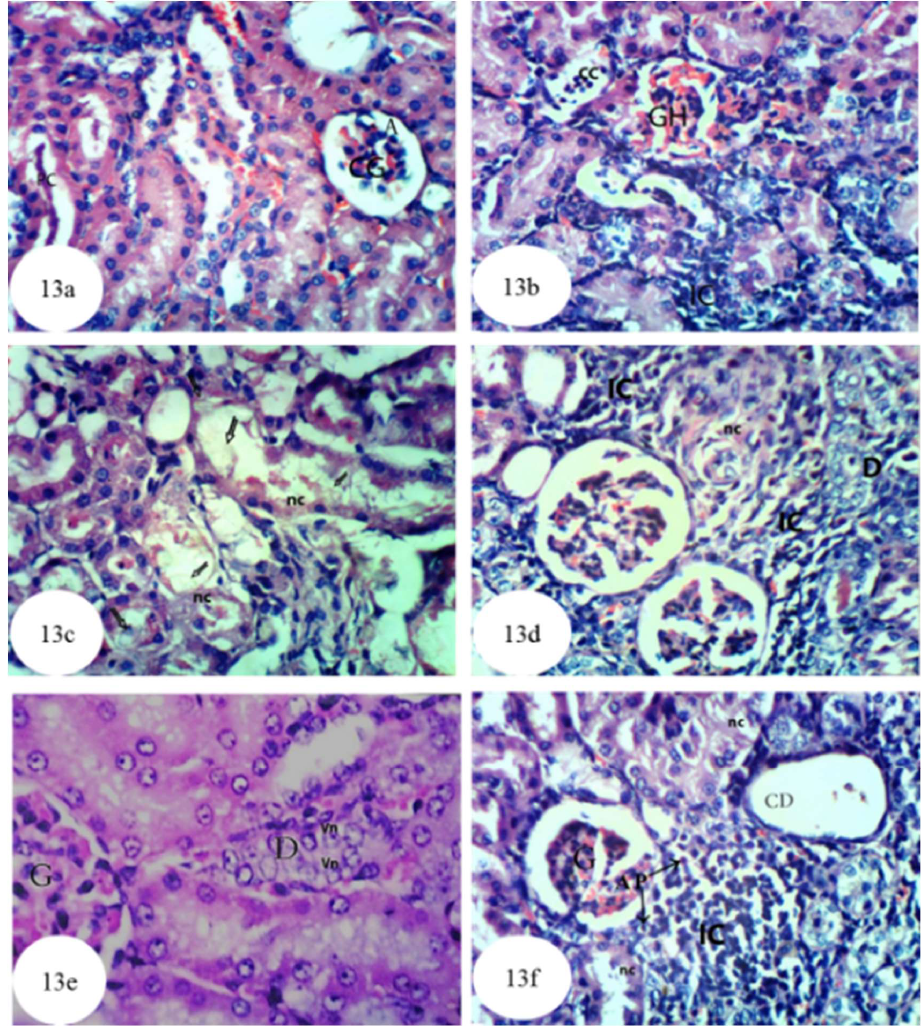
Figure 13. Photomicrographs of hematoxylin and eosin stained sections of kidney of ethylene glycol control rat showing atrophy (A) and congestion (CG) of the glomerular tufts and presence of protein casts (PC) in the lumen of the renal tubules ( a ) (×400); interstitial nephritis marked by inflammatory cell (IC) infiltration and cellular casts (CC) in the lumen of the renal tubules and glomerular hemorrhage (GH) ( b ) (×400); necrosis (nc) of renal tubules and presence of oxalate crystals (arrows) in the lumen of the renal tubules ( c ) (×400); dysplastic tubular cells (D) and focal necrosis (nc) of the renal tubules associated with massive inflammatory cells (IC) infiltration ( d ) (×400); enlarged vesicular nuclei (vn) with irregular arrangement ( dysplasia and anaplasia ) (D) in the lining epithelium of the renal tubules ( e ) (×256); and cystic dilatation (CD) of the renal tubules, focal inflammatory cells (IC) infiltration, necrosis (nc) and apoptotic cells (AP) ( f ) (×400).